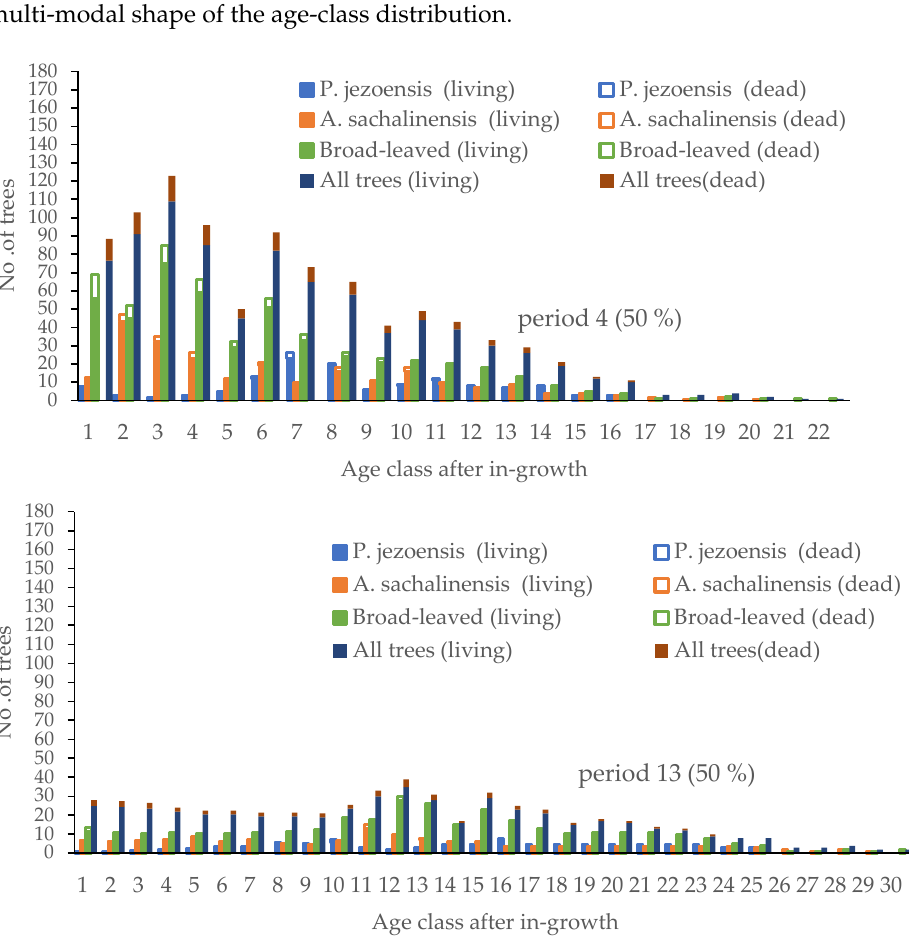
Figure 8. Future prediction results (50% scenario) of upcoming 100 years of conifer and broad-leaved trees; the rest of the periods are attached to the appendix section.